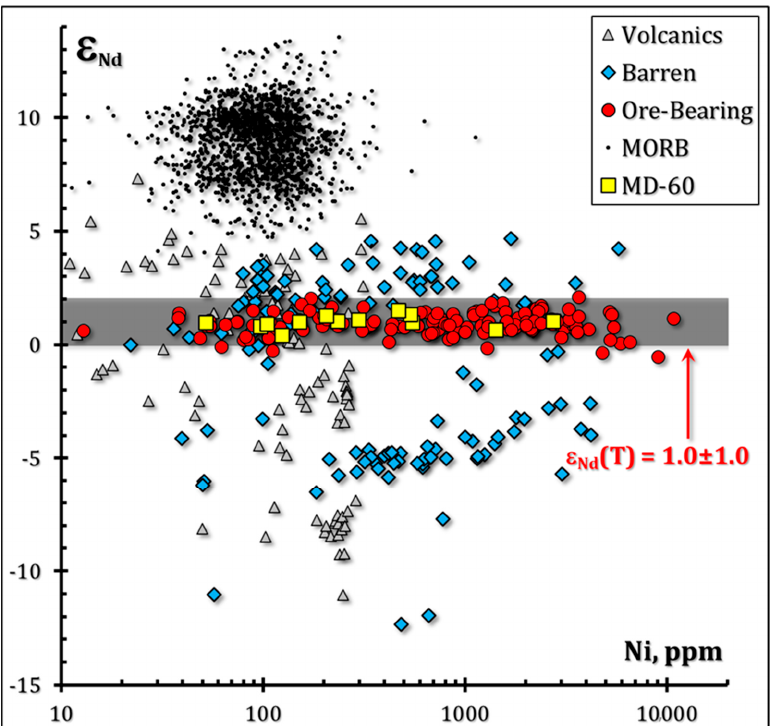
Figure 13. Ԑ Nd (T) and Ni contents in volcanics, ore-bearing, and barren intrusive rocks. Note the absence of correlation between e Nd (T) and Ni, suggesting that metal enrichment was not related to anomalous material assimilation by parent magmas. Compositions of the samples from MD-60 borehole on this plot are in good agreement with ore-bearing data. A common inverse correlation between Nd and Sr isotopic ratios is observed in barren intrusive and volcanic rocks only, whereas it is absent in the ore-bearing intrusive bodies (Figure 14) mostly due to a very narrow range of the Nd isotopic ratio variations in the ore-bearing rocks.